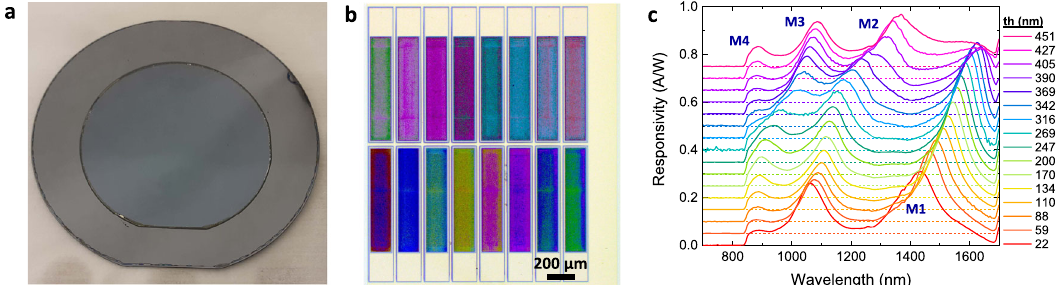
Fig. 2 Realization of a multi-pixel array. a 2 ″ InP membrane integrated on a Si wafer via adhesive wafer bonding. b Optical microscope image of a detector array (magni fi cation 5x). c Measured responsivity for 16 pixels of the same array with measured Ma-N thickness increasing from 22 to 451 nm. Resonant modes are indicated by M1 to M4. An offset, with increasing steps of 0.05 A/W, is added for clarity. The zero-responsivity axis for each curve is indicated by the dashed line in the corresponding